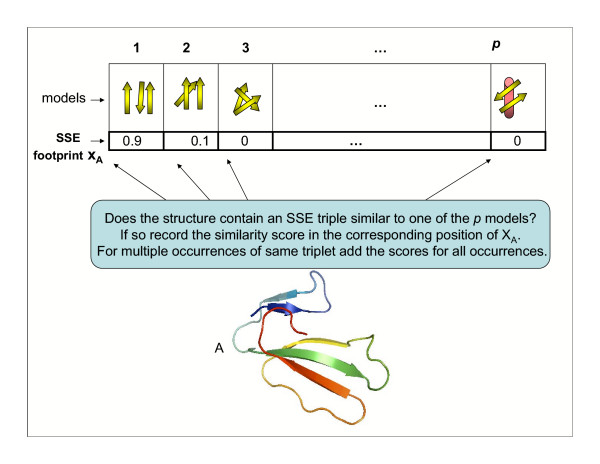
Computing an SSE footprint. Once a set of p models is selected, each protein domain is mapped to a vector in Rp, where each dimension corresponds to a particular model and records the "weighted" number of times the model is observed in the structure of the domain. Here a protein structure A is mapped to an SSE footprint xA.